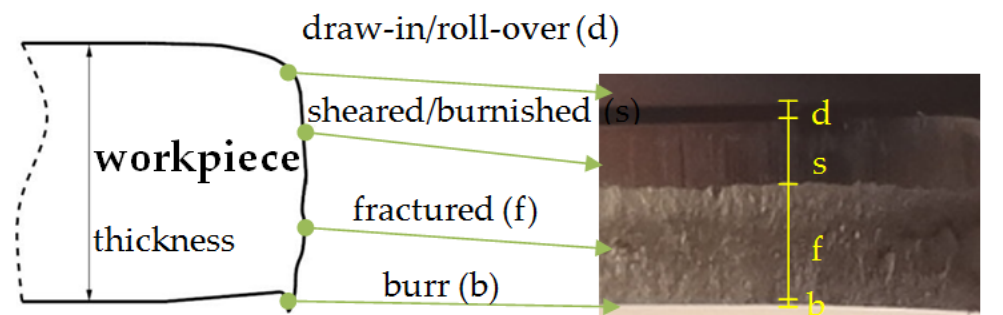
Figure 16. Zones on workpiece cut surface.